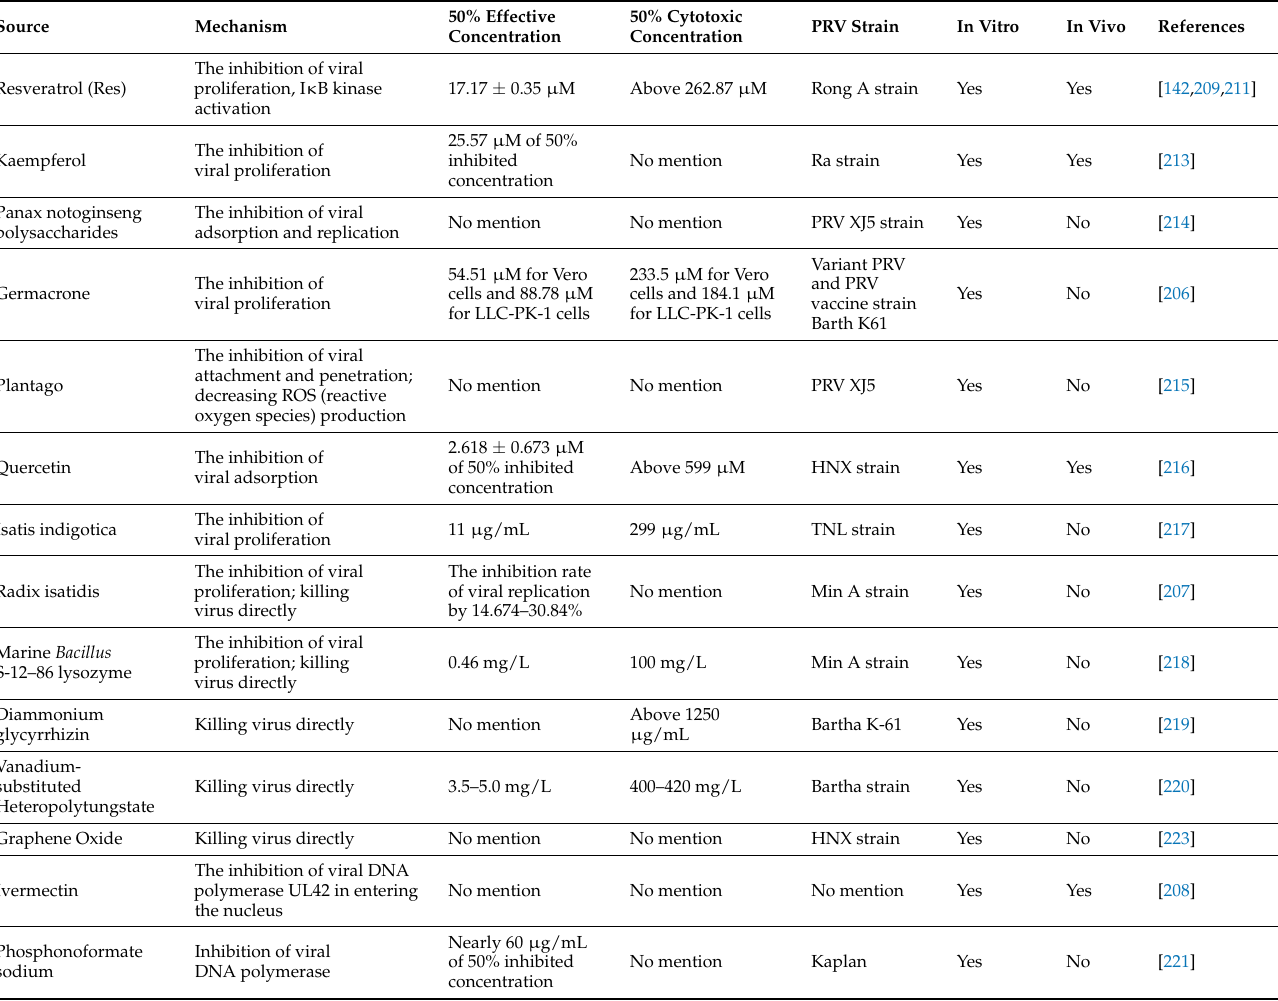
Table 4. Overview of compounds with anti-PRV infection